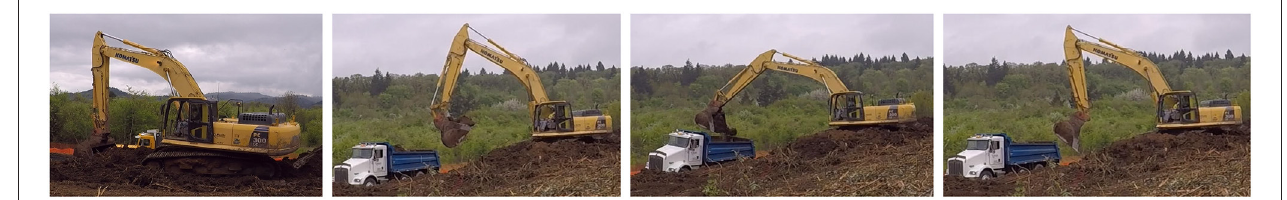
FIGURE 4 | Typical excavator operation for earthmoving (starting from the left, digging, swinging loaded, dumping, and swinging empty).